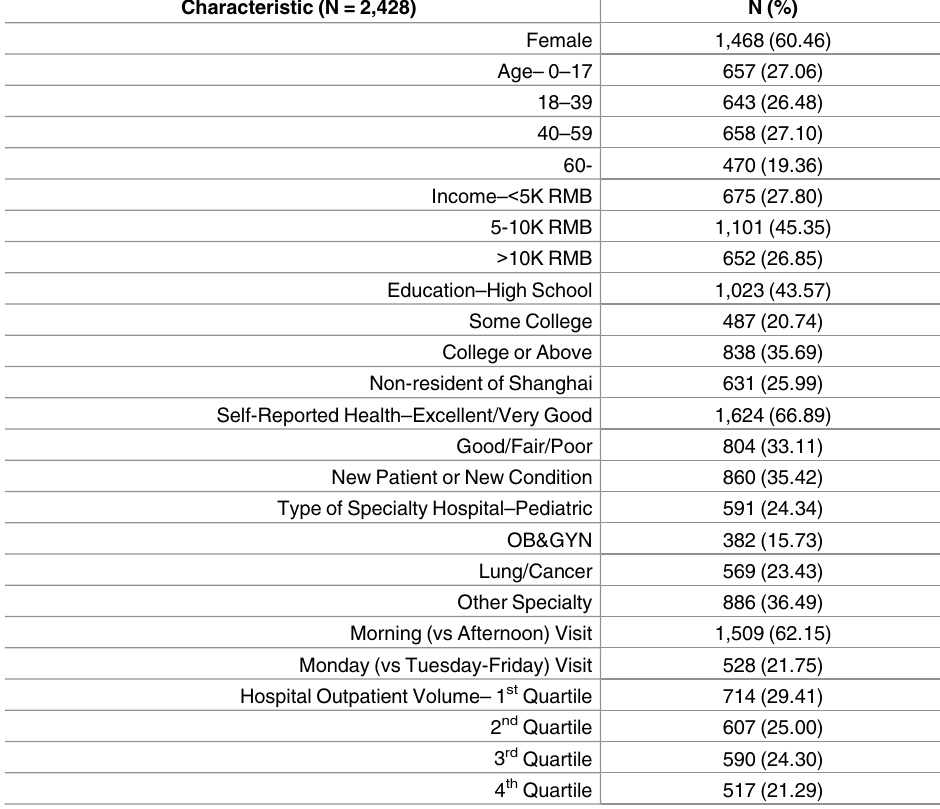
Table 4. Descriptive statistics of outpatients at public hospitals in Shanghai: Specialty hospitals Characteristic (N =